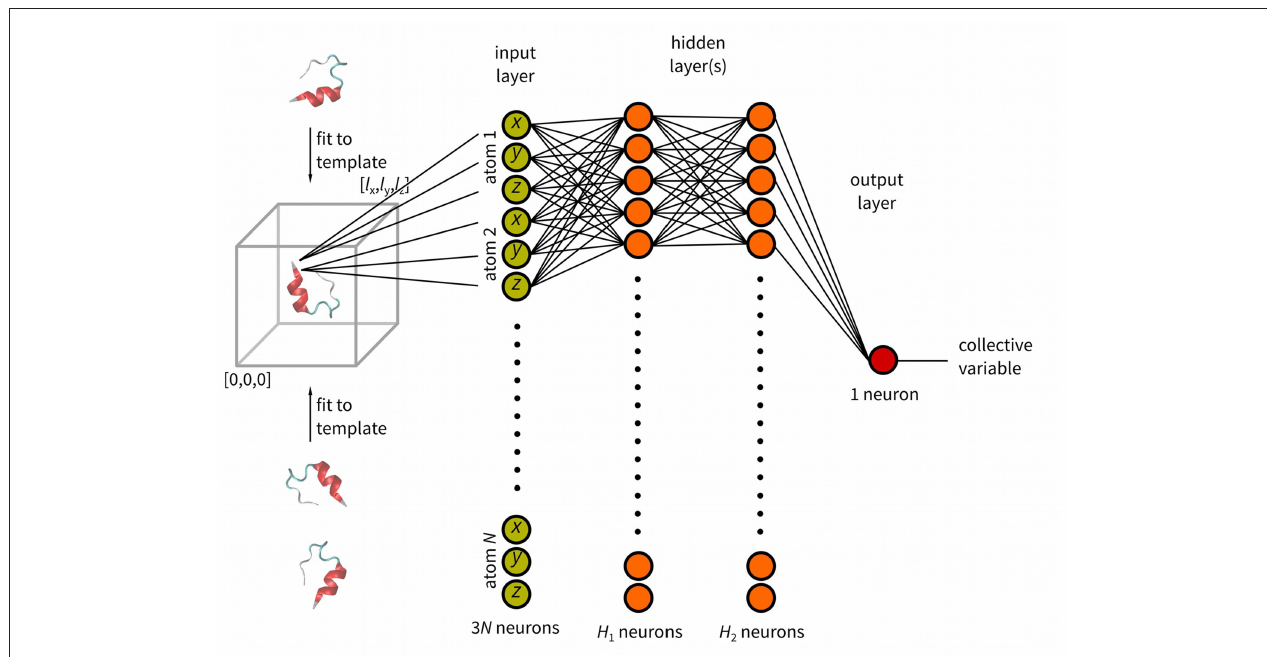
FIGURE 1 | Schematic representation of anncolvar function. Three input files are needed for training: (i). reference structure (in PDB) of the molecule located in the center of box with one corner with coordinates [0, 0, 0] and size of [ l x , l y , l z ], (ii) training trajectory (without molecules broken by periodic boundary condition) and, (iii) file containing precomputed values of the CV for each snapshot of the training trajectory. The program generates the input file for PLUMED. In PLUMED the molecule is fit to the template (reference structure) and the CV is calculated by neural